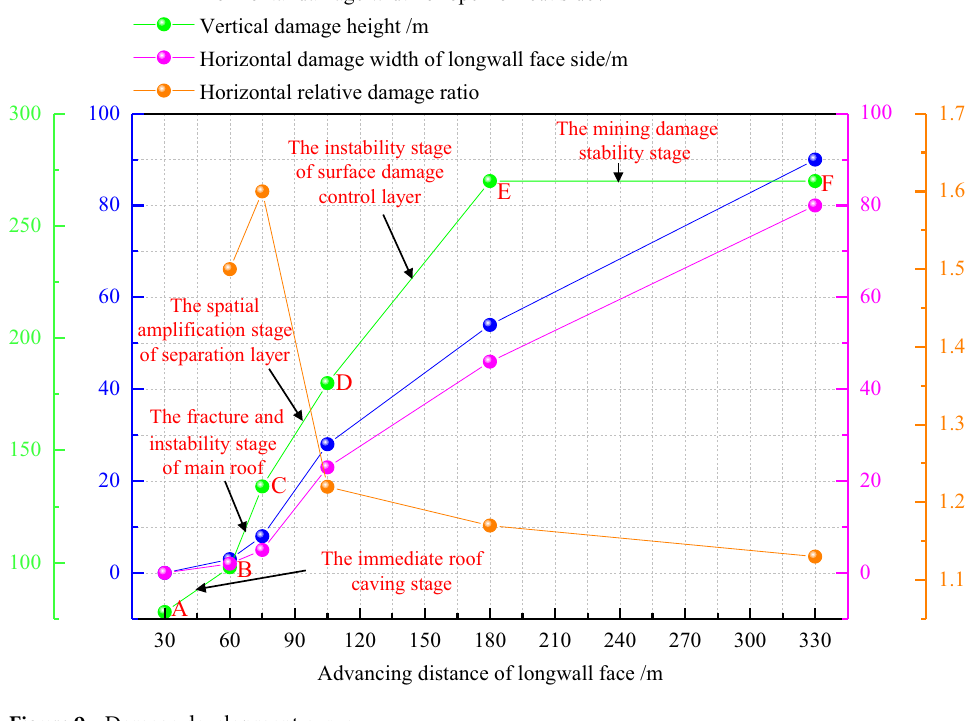
Figure 9. Damage development